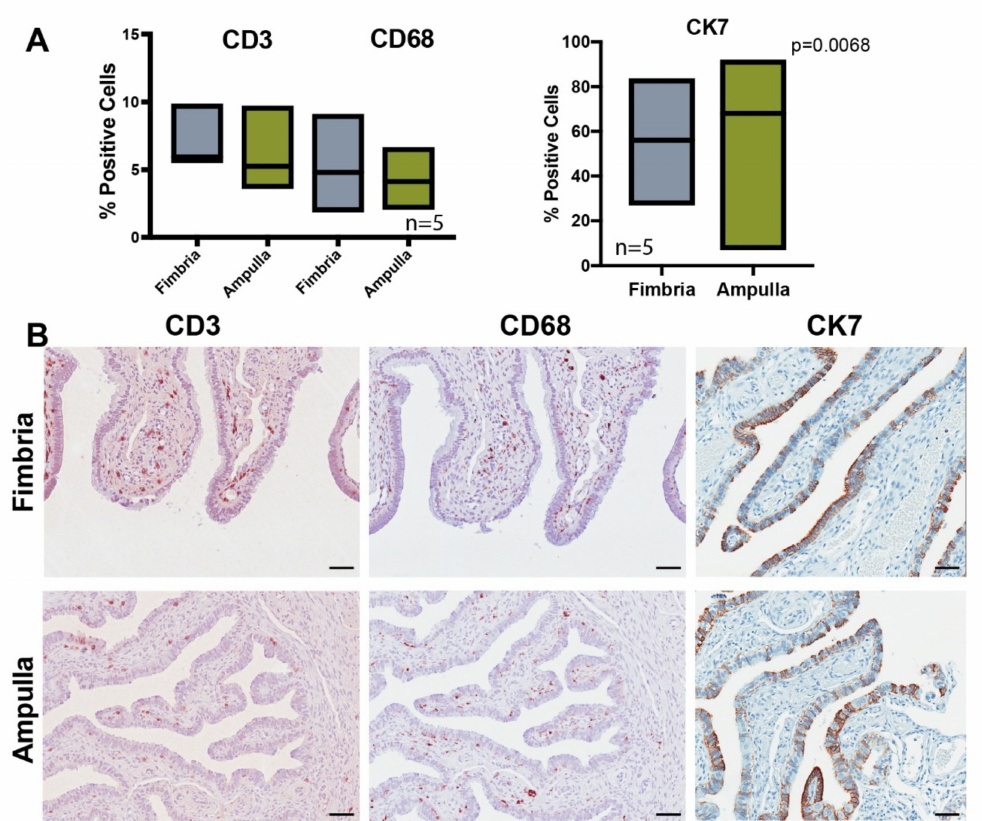
Figure 5. Immune cell profiling of the fimbria and ampulla show di ff erences in immune cells between fimbria and ampulla. ( A ) Immunohistochemistry of CD3, CD68 and CK7 markers was performed on five cases to show the percentage of cells positive for each marker across fimbria and ampulla. Only CK7 showed significant di ff erences in expression between the fimbria and ampulla. Statistical tests using an unpaired t-test were used in all comparisons ( p < 0.05). ( B ) Bright field microscopic images of fimbria and ampulla tissue sections show di ff erences in protein expression of CD3, CD68 and CK7 between the two tissues. Scale bar: 200 µ